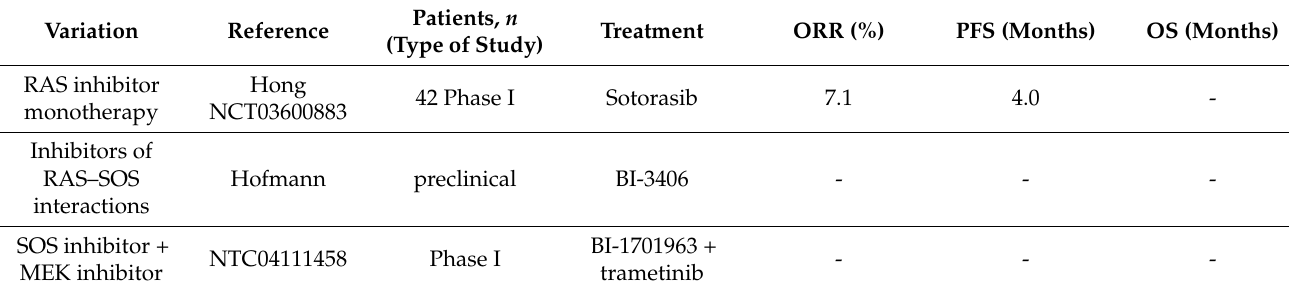
Table 3. RAS and SOS inhibitors in development in colorectal